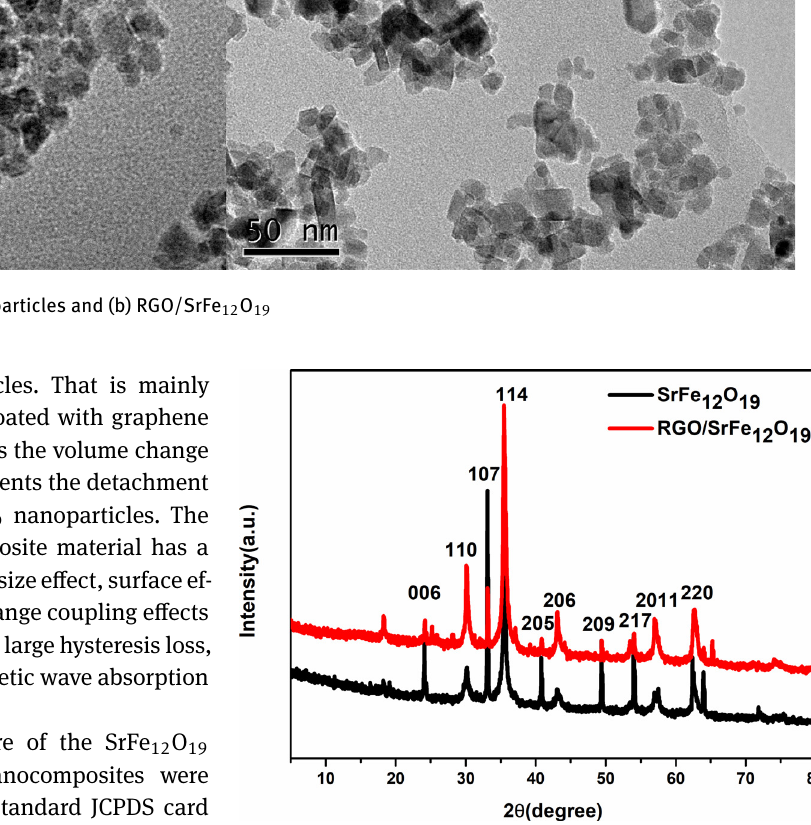
Figure 2: XRD patterns of SrFe 12 O 19 nanoparticles and RGO/SrFe O 12 19